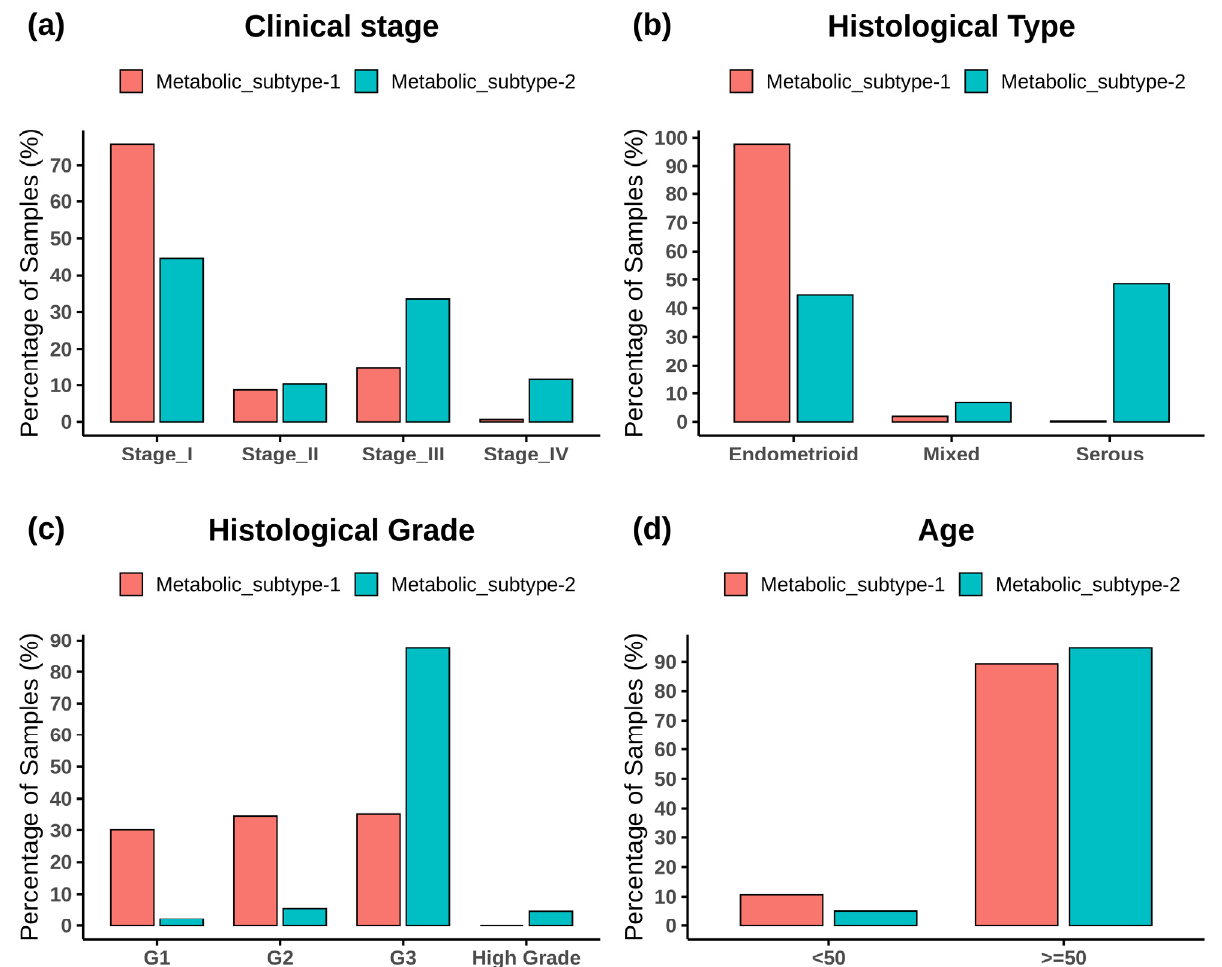
Figure 3. The bar plot shows the distribution of clinical variables in each metabolic subtype. ( a ) ( a ) Clinical stage, ( b ) histological type, ( c ) histological grade, and ( d ) Clinical stage, ( b ) histological type, ( c ) histological grade, and ( d ) age.